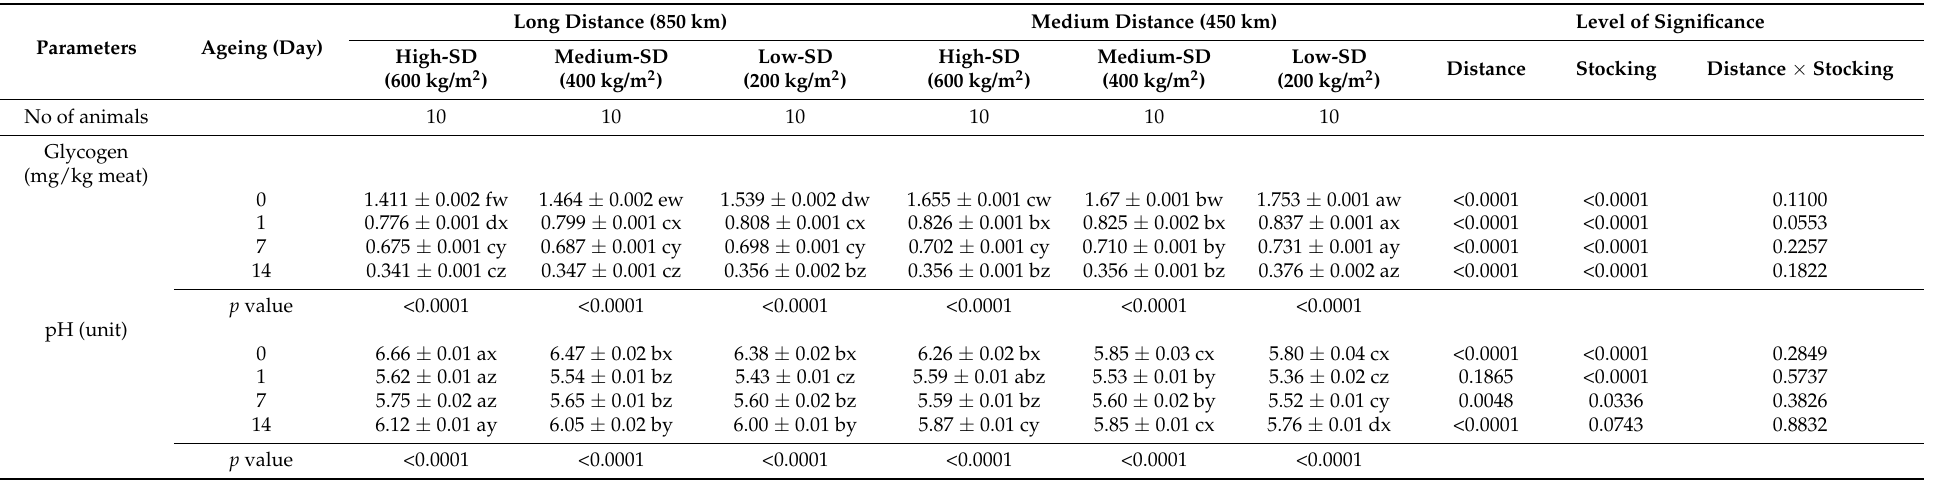
Table 2. Differences in the glycogen content and pH values of Longissimus lumborum muscle during postmortem ageing periods in cattle subjected to different distances and stocking densities (SD) during road